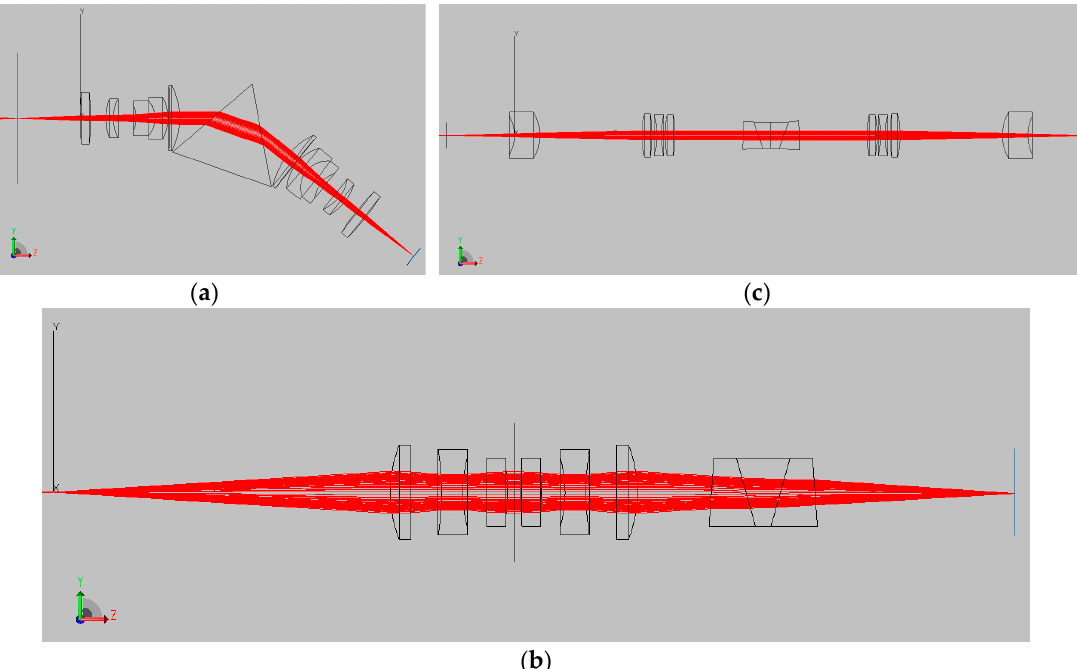
Figure 2. Example of ray propagations for three versions of Coded Aperture Snapshot Spectral Imager simulated by TracePro TM ( a ) Single Disperser CASSI; ( b ) Double-Amici CASSI; ( c ) Ultra-Violet CASSI (see references [18–20]).